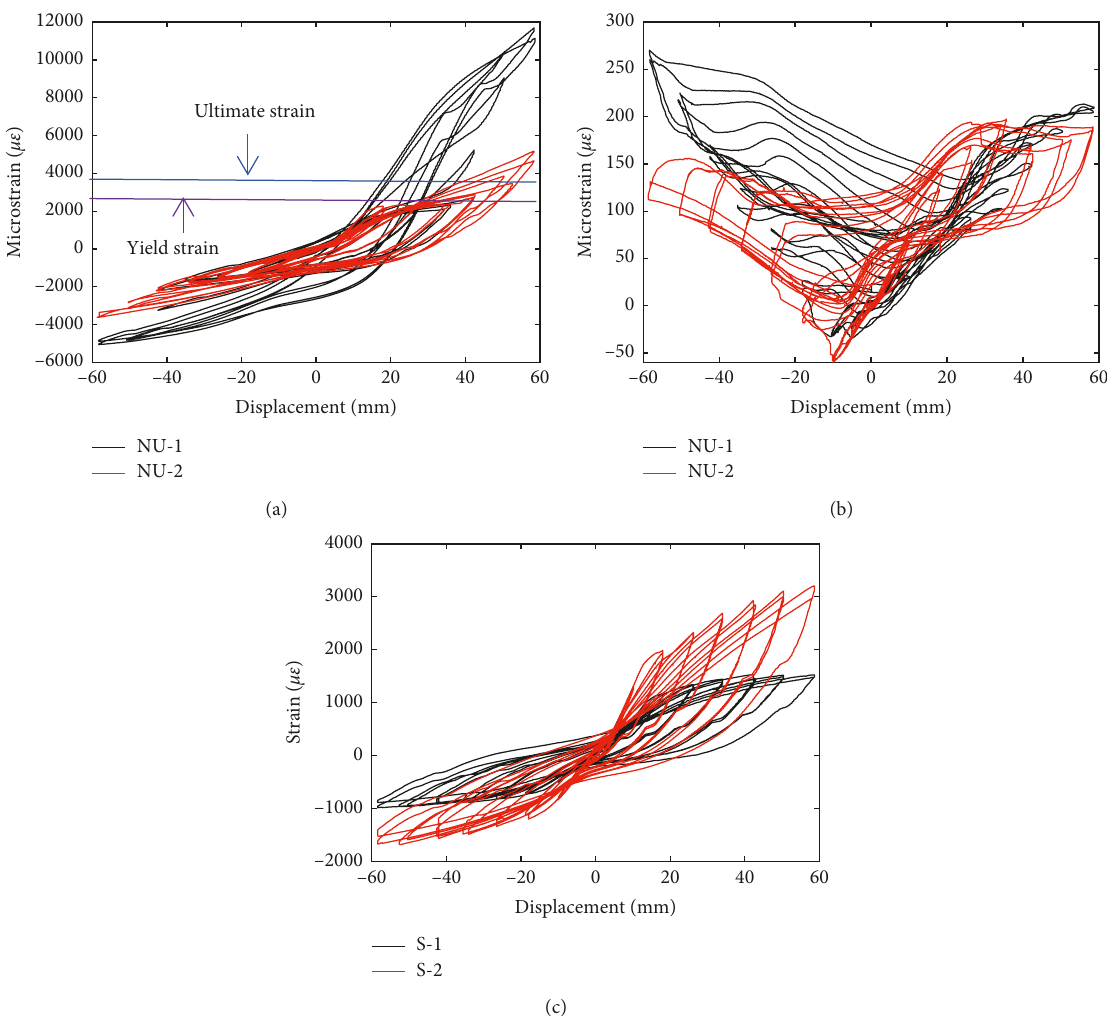
Figure 7: Strain analysis: (a) longitudinal reinforcement; (b) stirrup; (c) BFRP sheet of